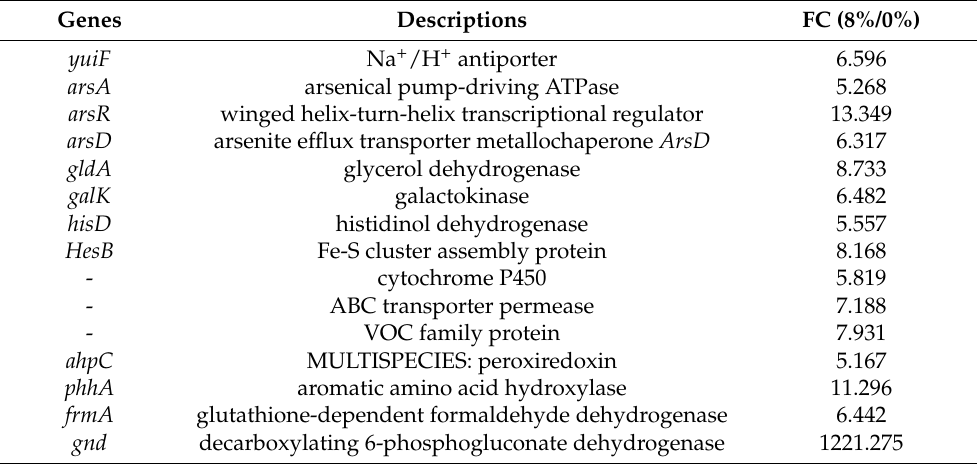
Table 2. Transcriptome upregulates genes and their annotations when FC (8%/0%) ≥ 5. Genes